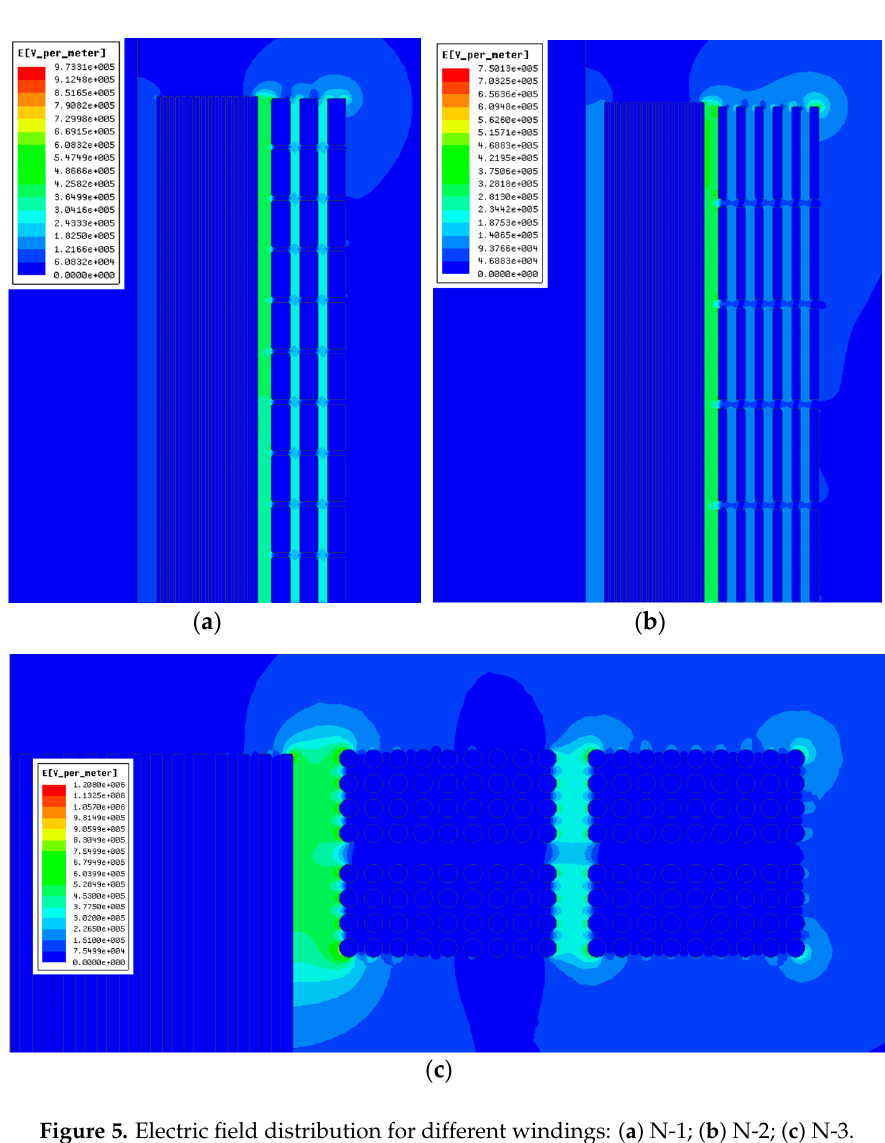
( a ) ( b ) ( c ) Figure 6. Electric field distribution for different windings: ( a ) N-4; ( b ) N-5; ( c ) N-6. Table 3. Maximum electric field intensities. Winding Type